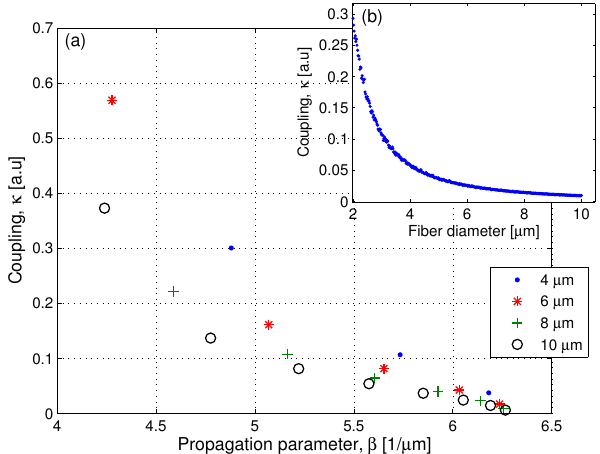
Figure 1. Calculated evanescence wave coupling strength. ( a ) Evanescence wave coupling strength as a function of the propagation vector for fibers with different diameters showing an increased coupling strength for high-order modes. ( b ) Evanescence wave coupling strength of the Gaussian mode as a function of the fiber thickness showing an exponential increased coupling strength for thinner fibers.